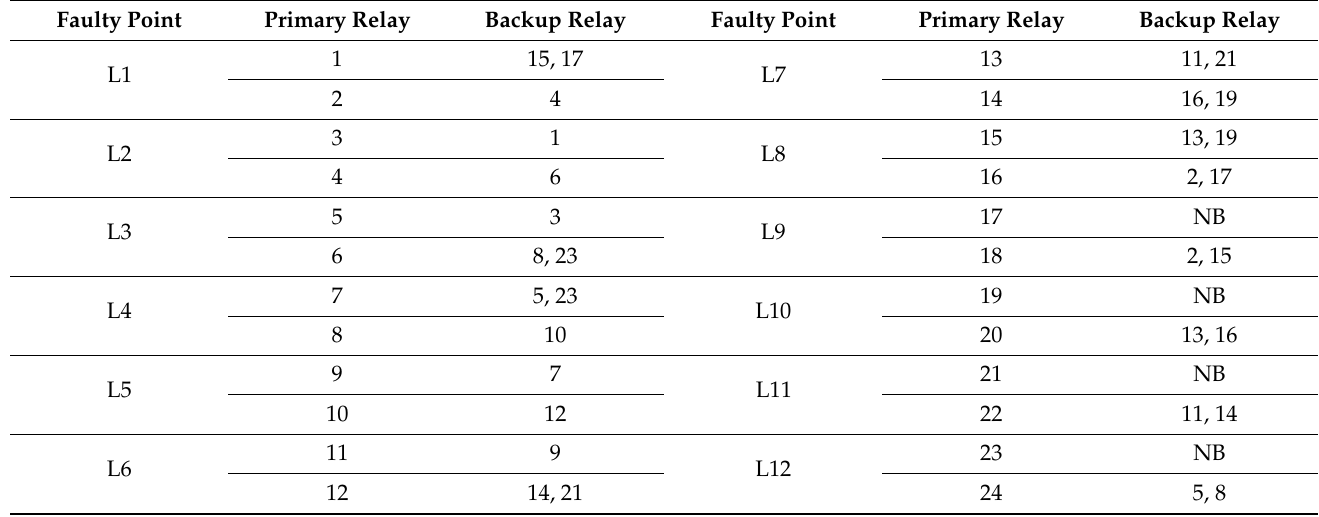
Table 1. Relationships between primary and backup relays at different fault points.